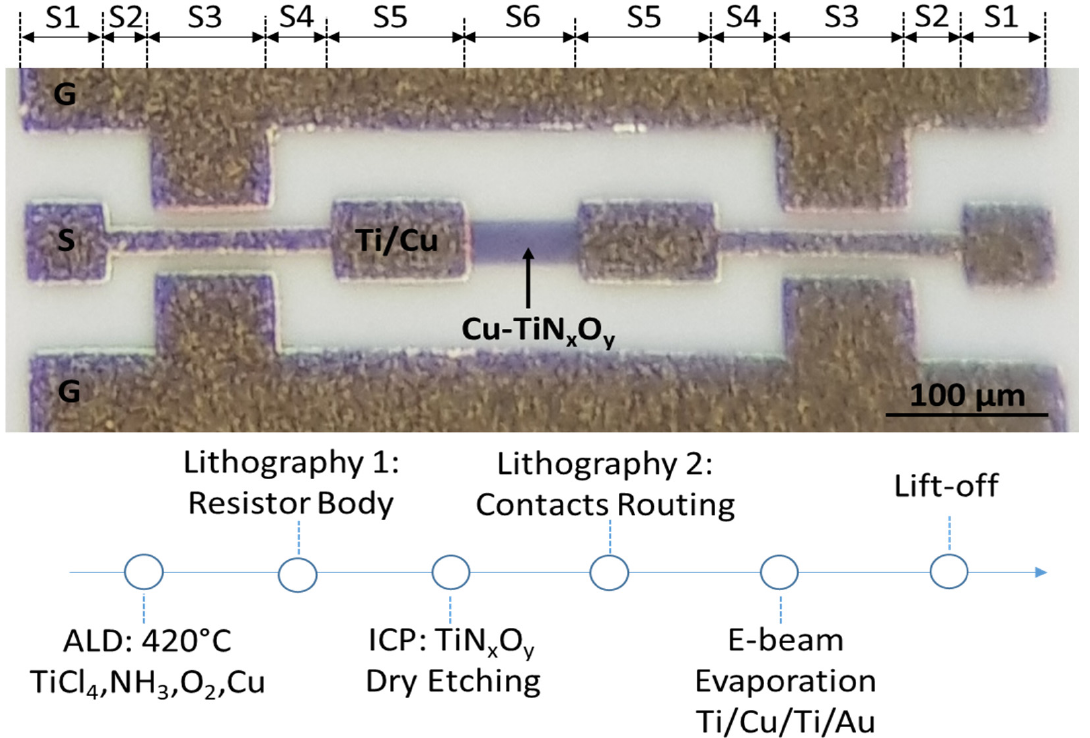
Figure 1. RF resistor fabricated from 22 nm thick Cu-doped TiN x O y film grown by ALD. The resistor body is connected to ground-source-ground (GSG) copper routing designed for DC/RF measurements. Titanium was used as the copper adhesion layer. The structure is schematically broken into S1–S6 sections for high-frequency modeling. The fabrication process flow diagram is shown below the resistor image.